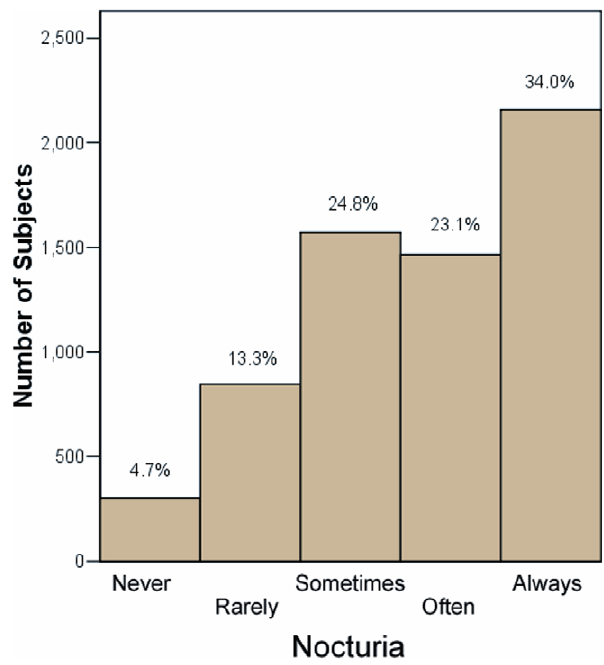
Table 2. Variables Associated With Presence Of Nocturia.